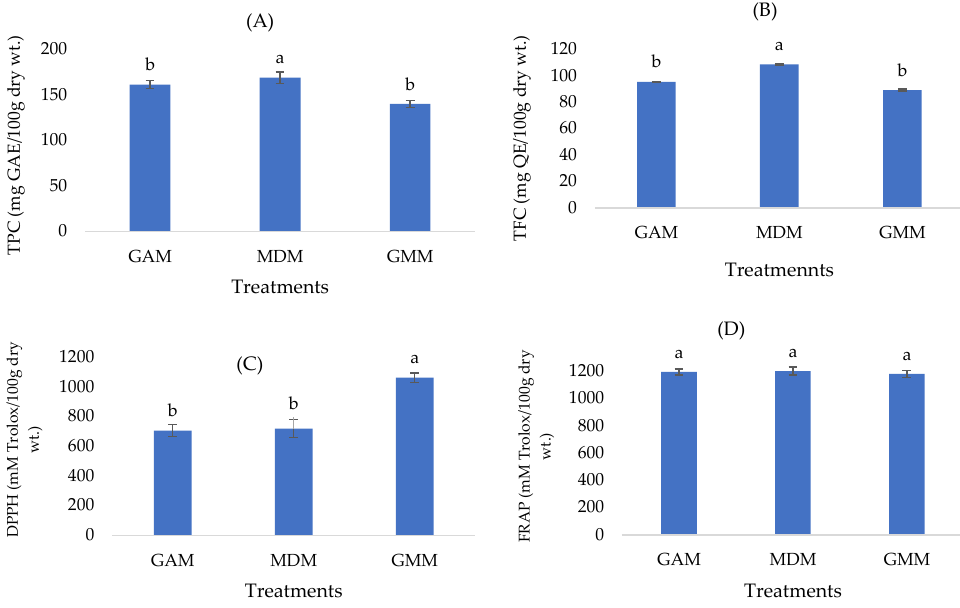
Figure 5. TPC: Total phenol compound ( A ), TFC: total flavonoid content, TFC ( B ), DPPH: 2,2- Diphenyl-1-picrylhydrazyl ( C ) and FRAP: Ferric Reducing Antioxidant Power ( D ) of CSP microcap- sules. GAM: gum arabic microcapsule (CSP extract coated with GA), MDM: maltodextrin microcap- sule (CSP extract coated with MD), GMM: gum arabic + maltodextrin microcapsule (CSP extract coated with the mixture of GA + MD). The letters “a, b” show the significant differences ( p ≤ 0.05).